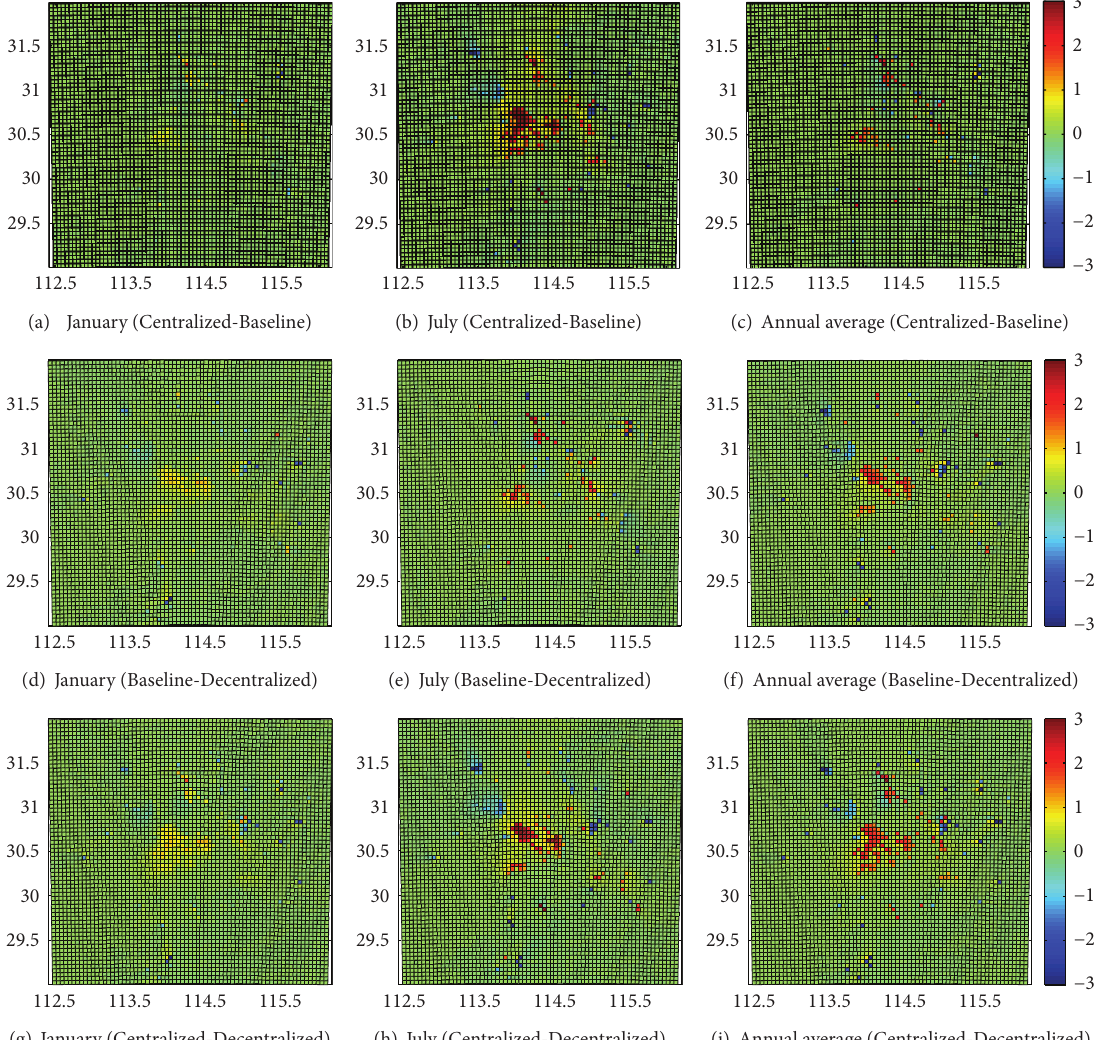
Figure 6: Spatial pattern of warming effect under different scenarios (unit: ∘